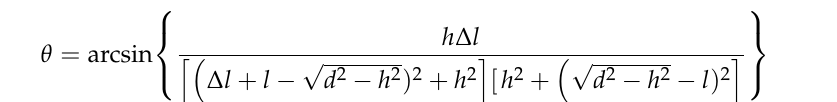
Figure 6. Schematic diagram of the electric actuator module: 1: stepping electric actuator, 2: hydrau- lic transmission, 3: kinematic pair, 4: gear lever. Under the control of the control system, the size of the stepping electric actuator ex- tension or contraction ∆𝑙 (mm) will drive the angle of the joystick swing 𝜃 (rad). The